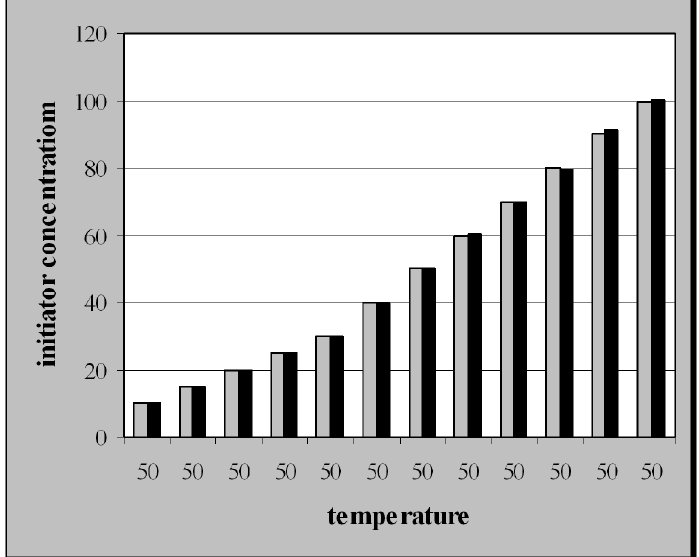
Fig. 20 Initial initiator concentrations obtained with MLP (2:12:4:2) in INN modeling at T = 50 o C ; gray bars - simulation training data; black bars { results of the inverse neural